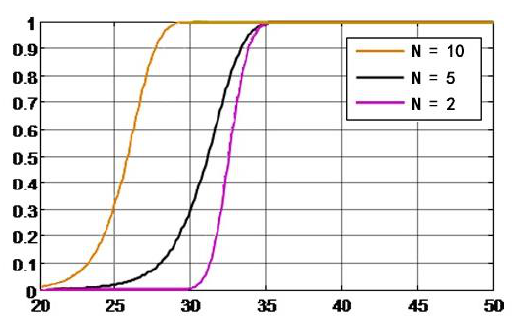
Figure 3: Change of detection probability with carrier to noise ratio